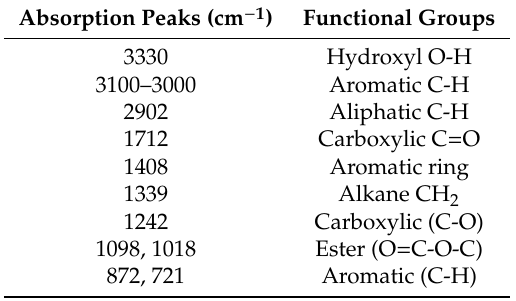
Table 1. Functional groups and their peaks found in ATR-FTIR spectrum of plasma treated and untreated P/C blend fabric.